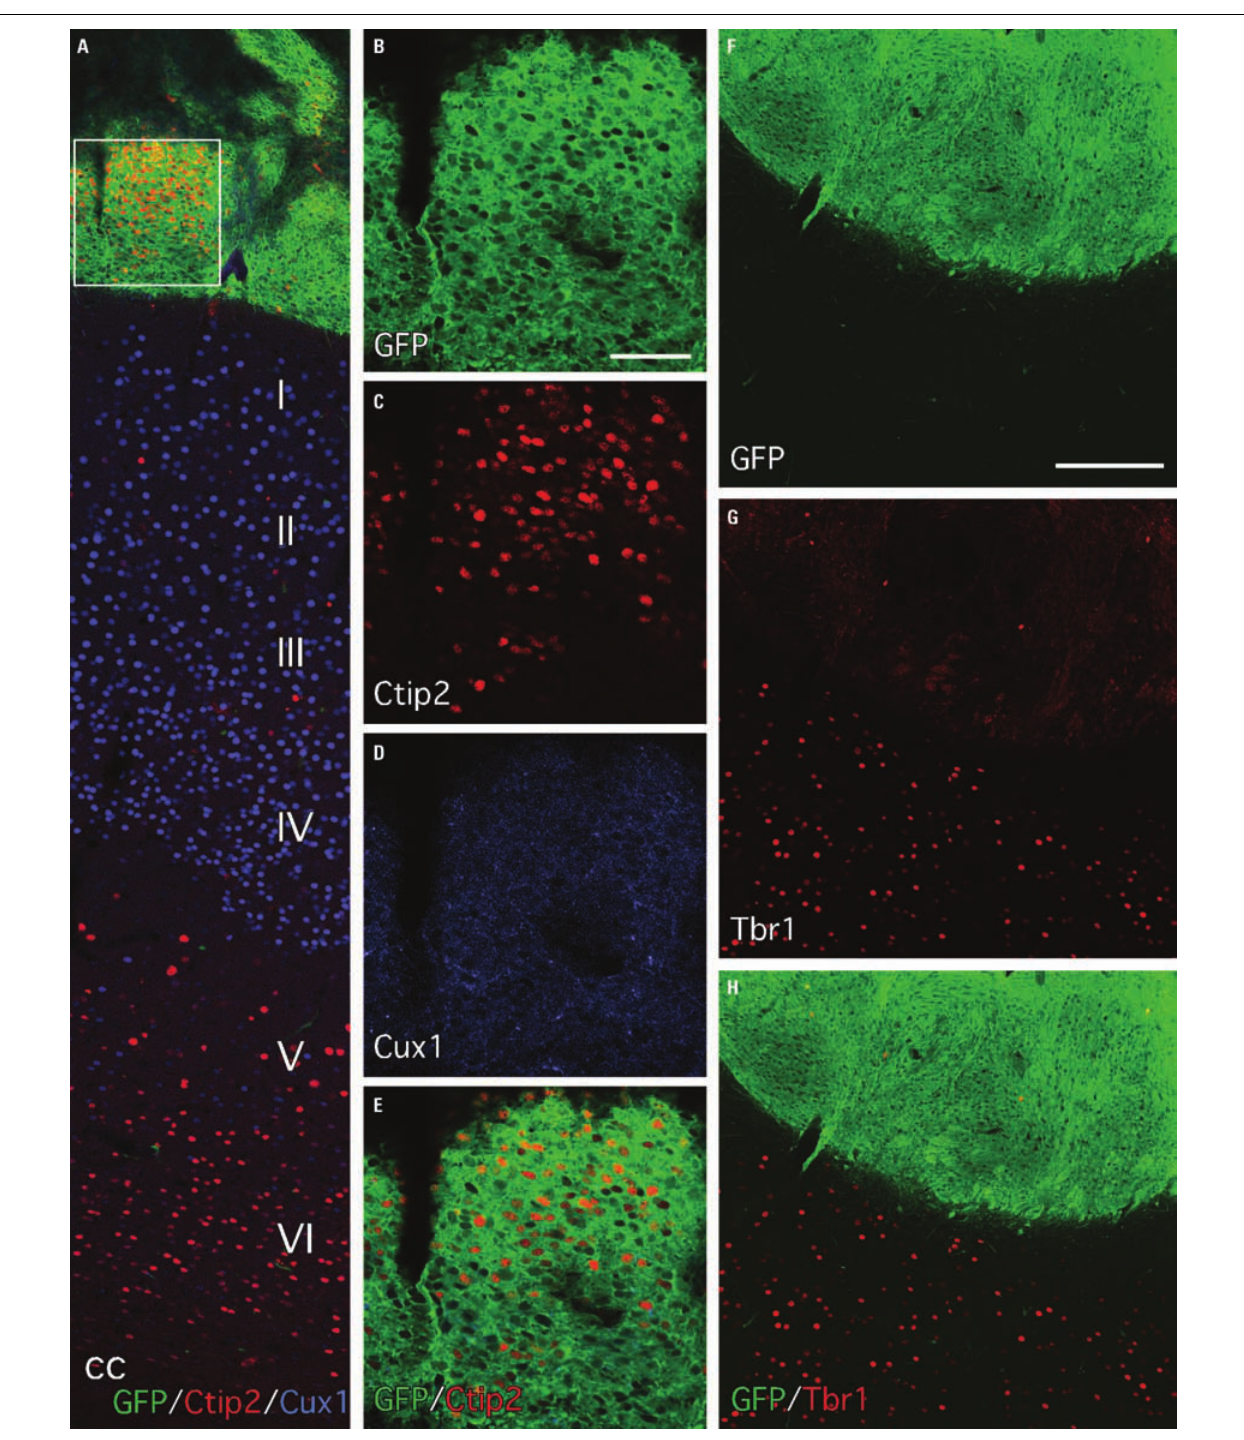
(A) shows that the grafts often contained discrete clusters of Ctip2 + cells but were largely devoid of Cux1 expression. (F–H) Tbr1 + cells were rare in the grafts but were uniformly distributed through the adjacent host cortex (red, separate color channels show fewTbr1 + cells in the GFP + graft area, and distributed in superficial cortical layers of the GFP − host tissue immediately dorsal to the graft – lower half of image). Scale bars: (B–E) 200 μ m, (F–H) 200 μ